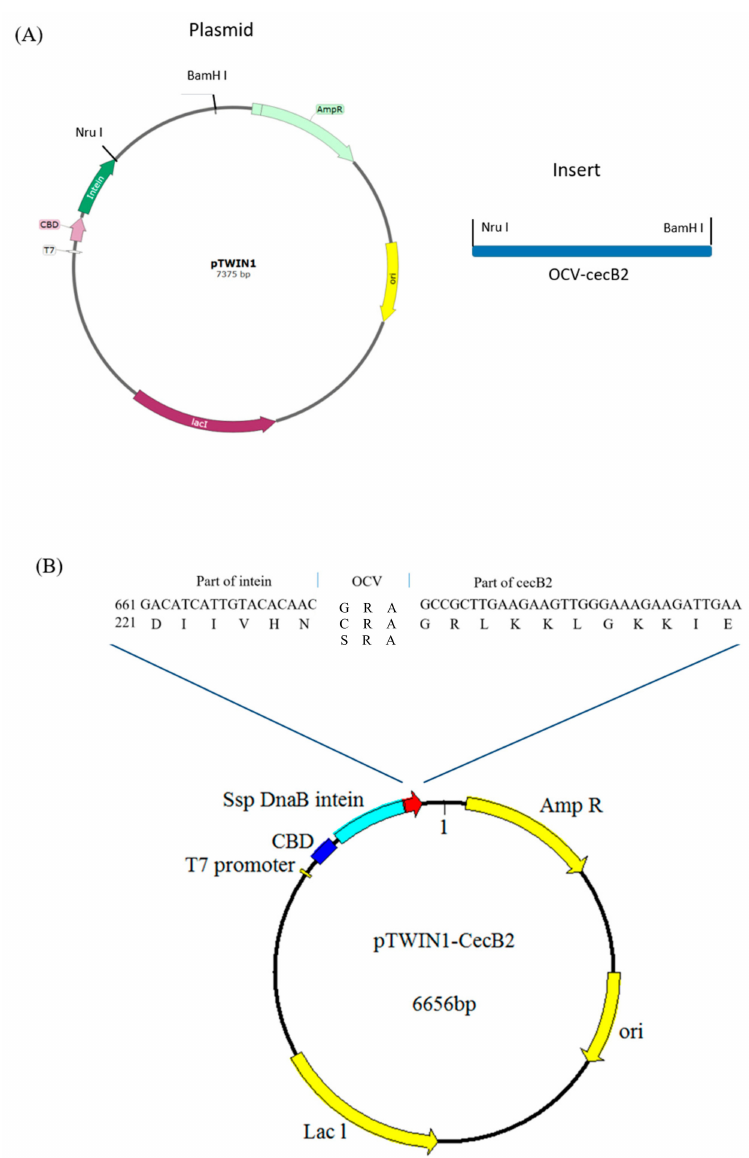
Figure 7. The plasmid and insert used in this study include ( A ) pTWIN1 and insert and ( B ) the construct of CBD-Int-OCV-cecbB2, where the OCVs were GRA, CRA, SRA, and the OCV amino acid number began from